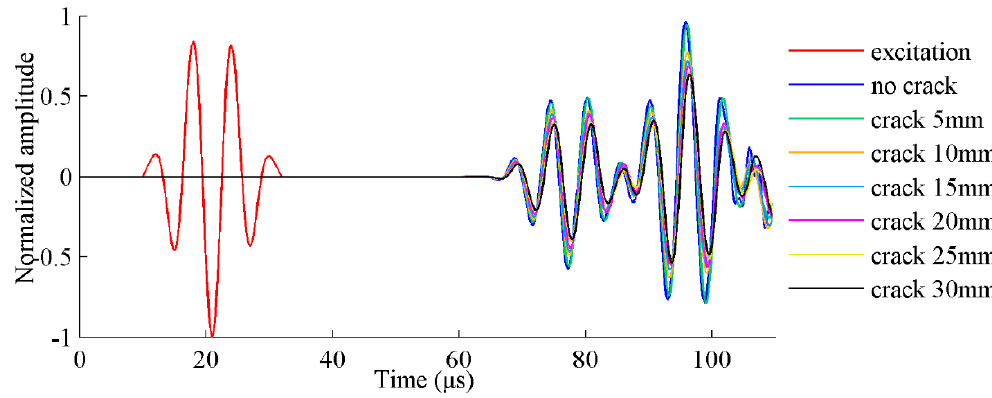
Figure 3. FE simulation of Lamb wave responses in a plate with different crack lengths.